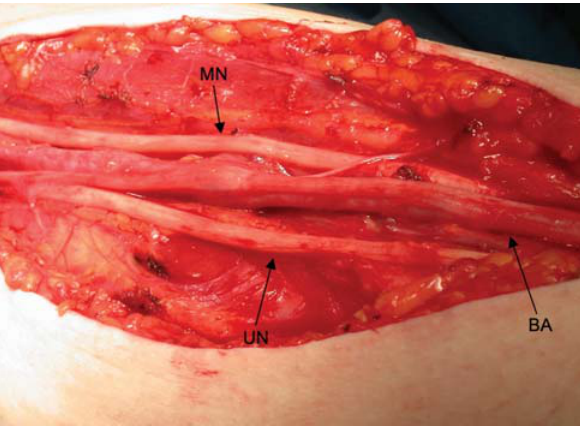
Fig.5 Neurovascularelementsareidenti fi edandreleased.Fasciaisexcised and adhesions are lysed. Nerves and vessels lay loosely in a healthy tissue bed. BA, brachial artery; MN, median nerve; UN, ulnar